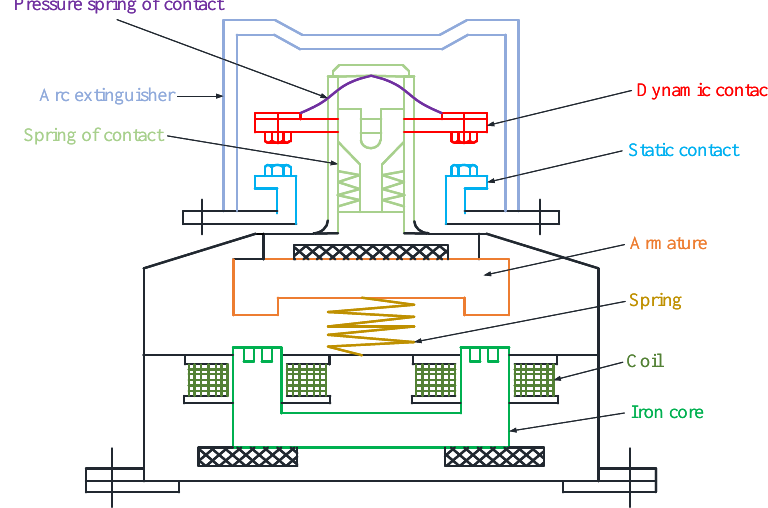
Figure 11. Structure diagram of AC